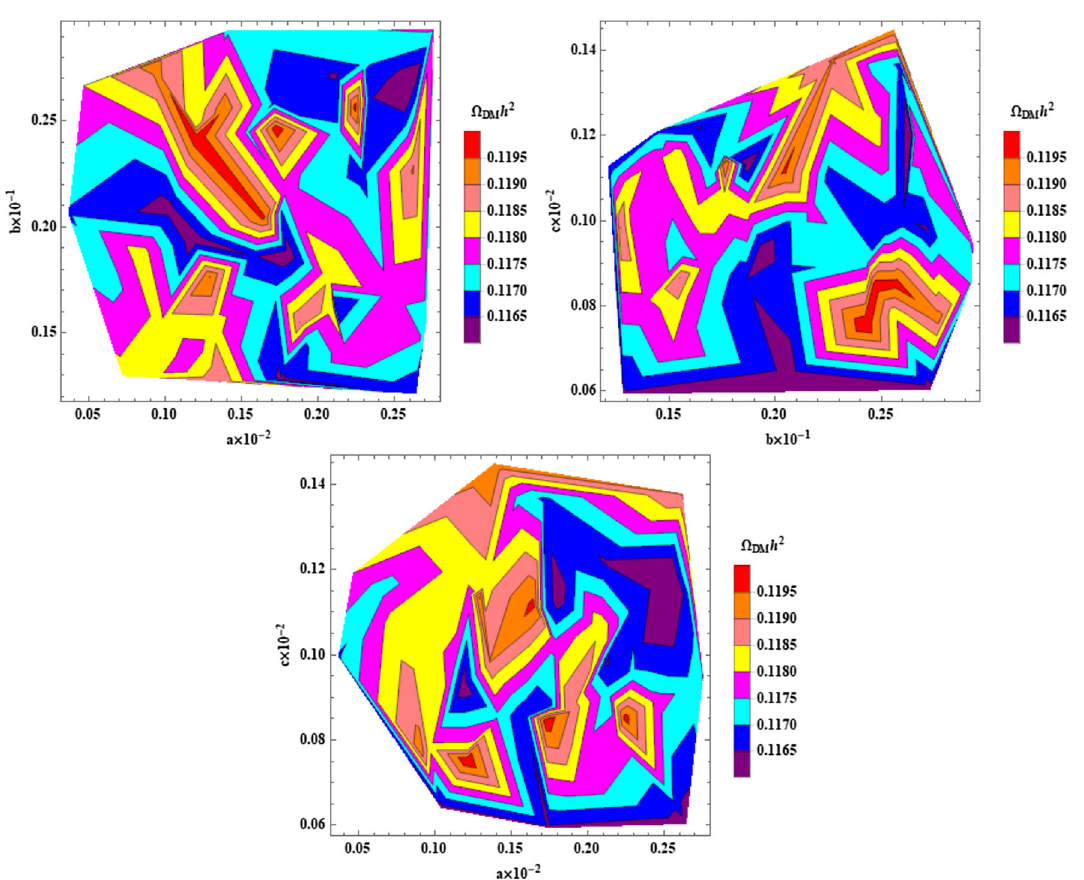
Fig. 15 Contour plot relating the Dirac masses a and b w.r.t the relic abundance ( (cid:20) DM h 2 ) of the DM candidate ( ξ ) (left panel), right panel shows variation of b and c with (cid:20) DM h 2 and in the middle we show a